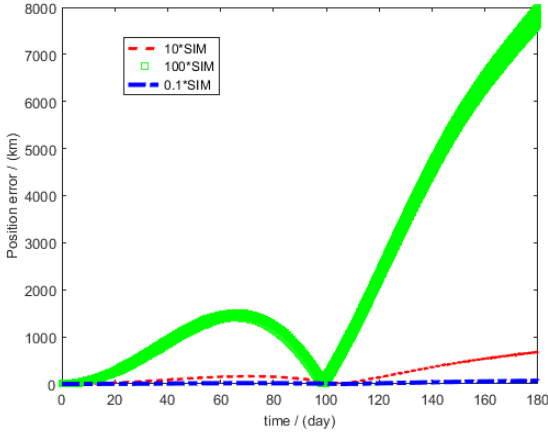
Figure 3. Effects of surface-mass ratio changes on ORB-2 forecast error